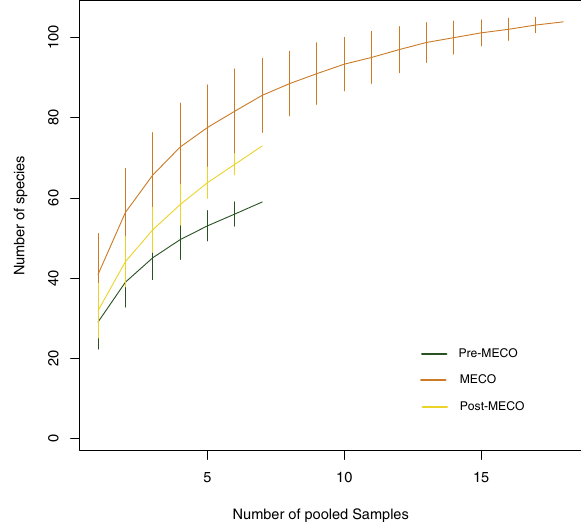
Fig. 4 Species accumulation curves for pre-MECO, MECO, and post- MECO intervals. Vertical lines denote bootstrapped 95% con fi dence